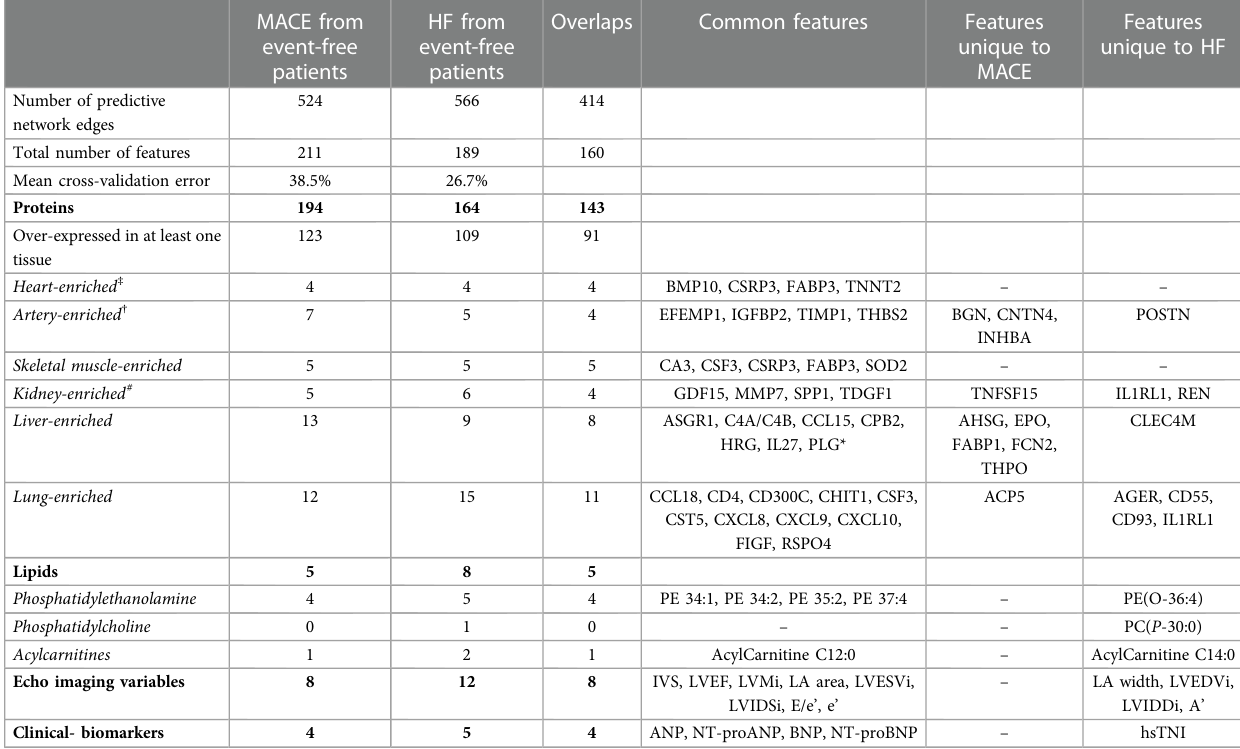
TABLE 2 Summary of the predictive subnetwork signatures of lipids, proteins and clinical markers in two comparisons, separating event-free post-MI patients from those with a future major adverse cardiac outcome (MACE) and from HF patients. MACE